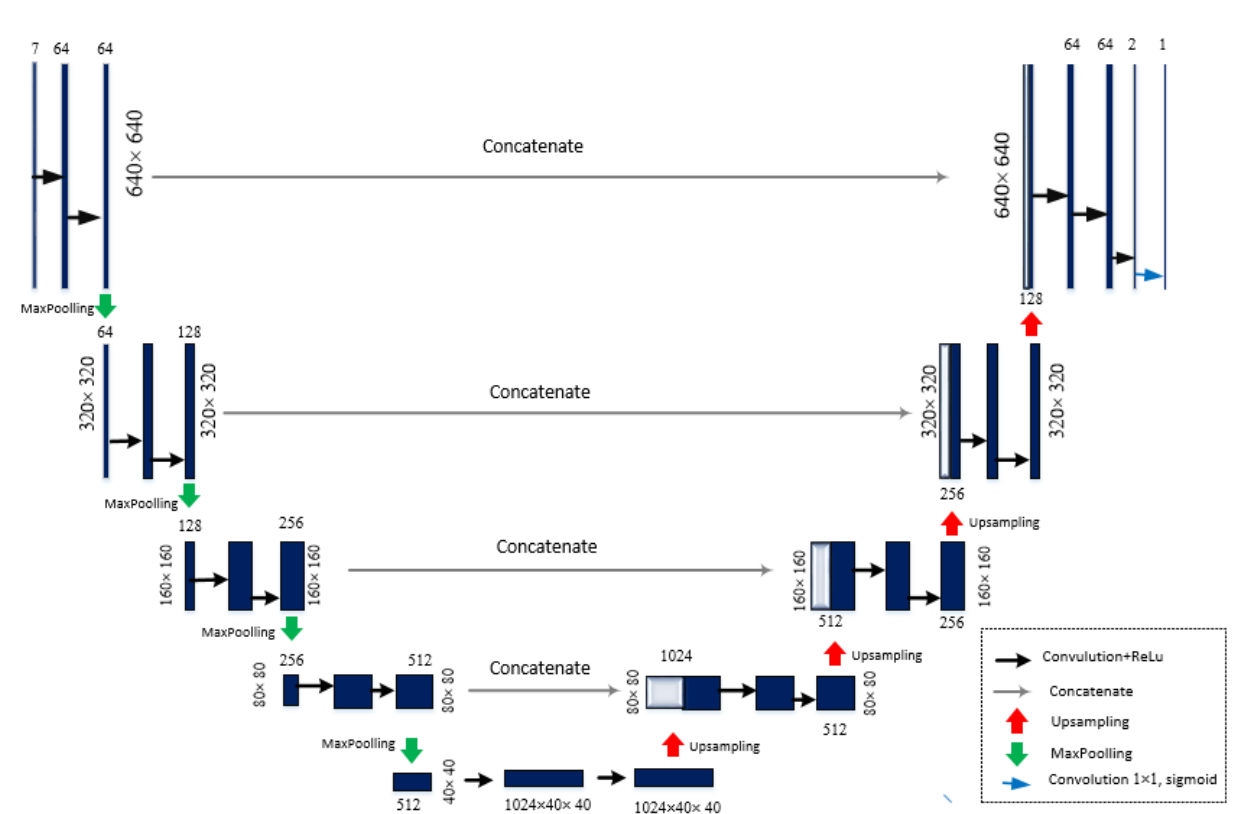
Figure 4. Structure of U-Net architecture (in case of 640 × 640